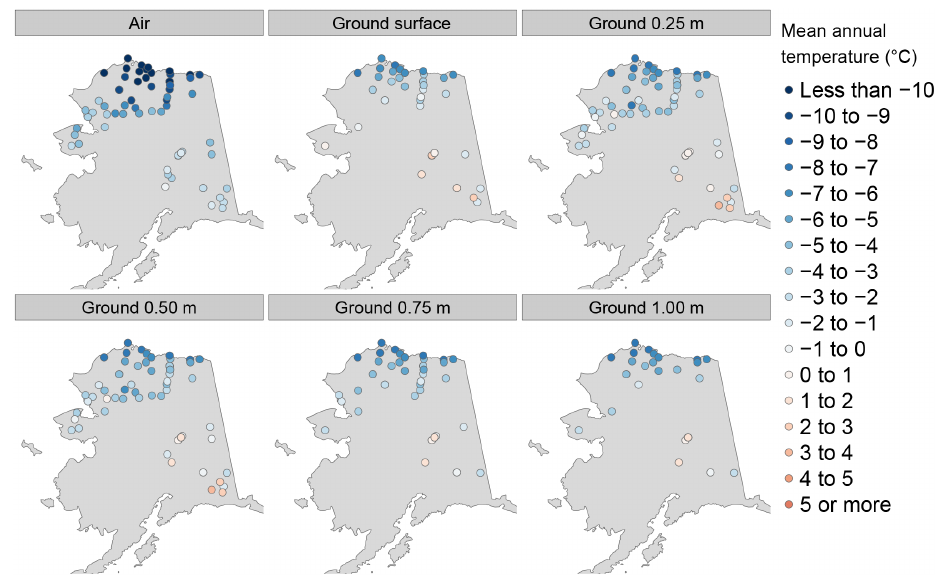
Figure 4. Overview of spatial distribution of mean annual air temperature, ground surface temperature, and ground temperatures at 0.25, 0.50, 0.75, and 1.00m.